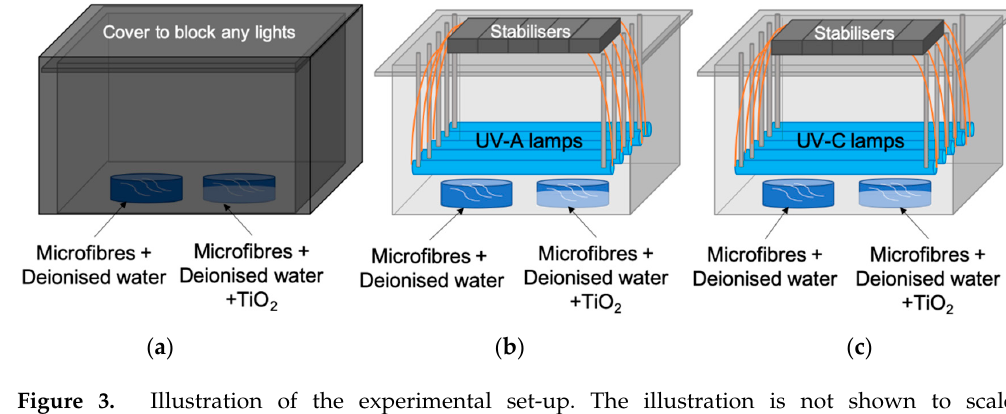
Figure 3. Illustration of the experimental set-up. The illustration is not shown to scale. Chamber ( a ) is covered to block any light. Chamber ( b ) is equipped with five UVA lamps; chamber ( c ) is equipped with five UVC lamps.